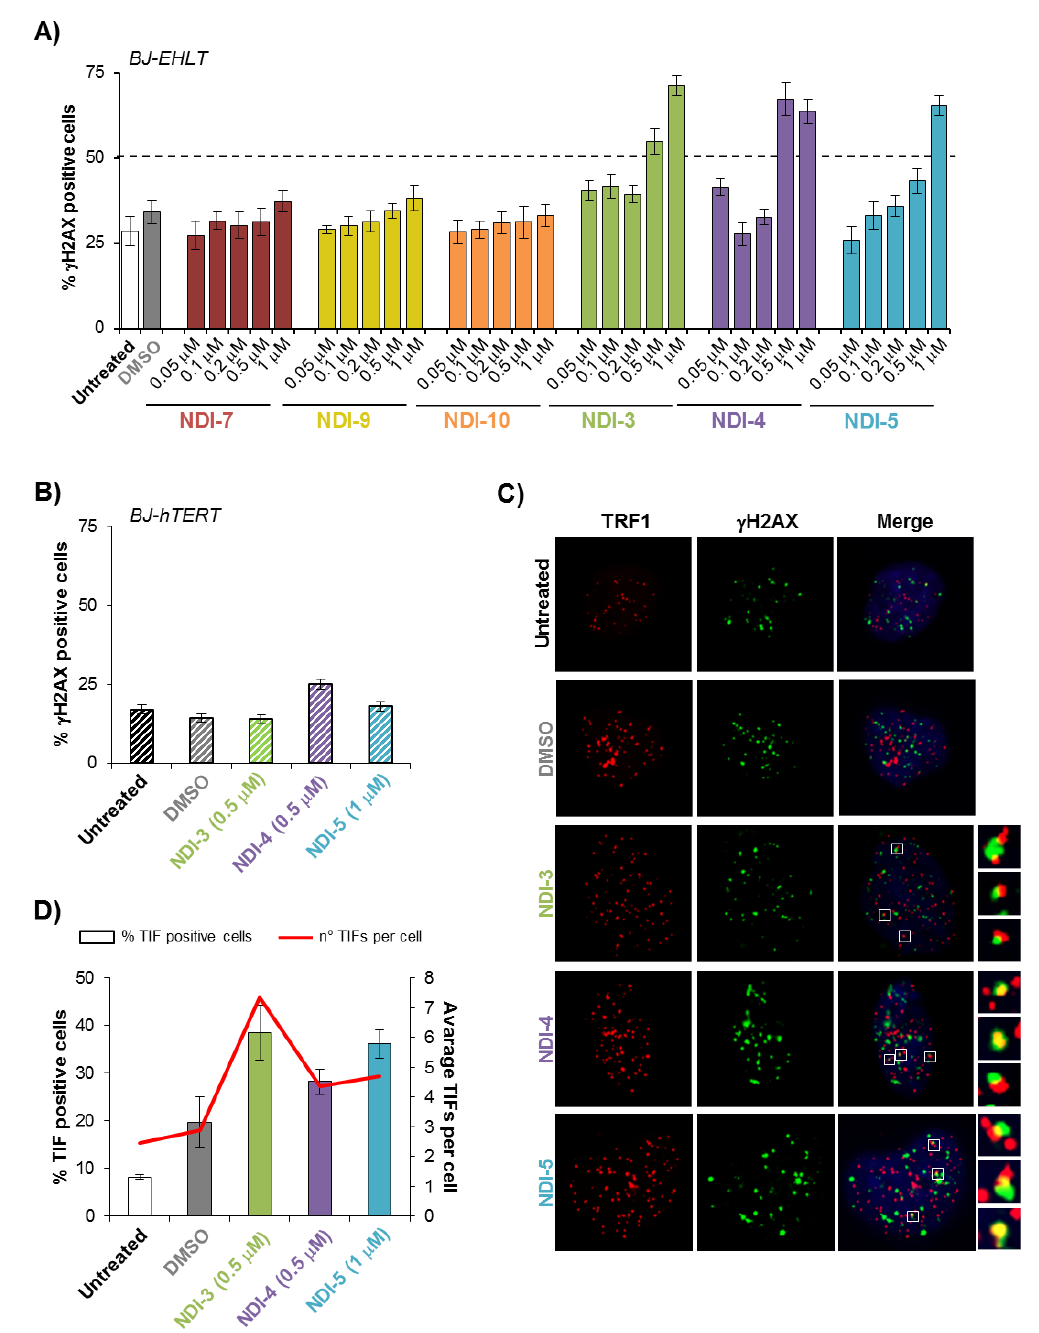
Figure 5. BJ-EHLT and BJ-hTERT fibroblasts were untreated or treated with DMSO or the investigated NDIs at the indicated concentrations for 24 h. Cells were processed for immunofluorescence (IF), using antibodies against γ H2AX and TRF1, to visualize the DNA damage and telomeres, respectively. ( A ) Percentages of γ H2AX-positive BJ-EHLT cells. ( B ) Percentages of γ H2AX-positive BJ-hTERT cells. ( C ) Representative merged images of IF of untreated and treated BJ-EHLT cells; γ H2AX spots in green, TRF1 spots in red and nuclei in blue. Enlarged views of Telomere Induced Foci (TIFs) are reported on the right panels of each picture. The images were acquired with a Leica Deconvolution microscope (magnification 63x). ( D ) Quantitative analysis of TIFs. The graph represents the percentages of TIF-positive cells (bars) and the mean number of TIFs per cell (red line) in the indicated samples. Cells with at least four γ H2AX / TRF1 foci were scored as TIF positive. Histograms show the mean values ± SD of three independent experiments.